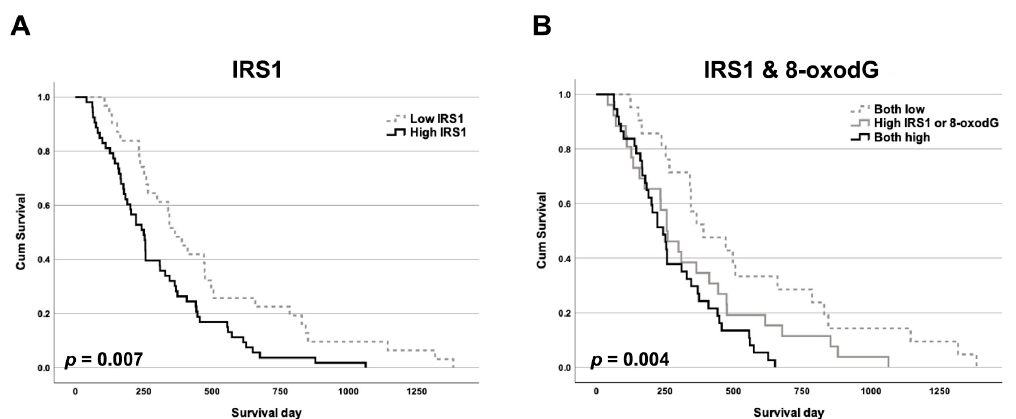
Figure 2. The Kaplan–Meier survival curves of patients against IRS1 and 8-oxodG levels. Impact on overall survival of CCA patients ( n = 84) of ( A ) IRS1 expression and ( B ) combined IRS1 expression and 8-oxodG formation. * p -value was assessed using the log-rank test. Table 2. The association between combination of IRS1 expression patterns and 8-oxodG formation and clinicopathological features of CCA patients .